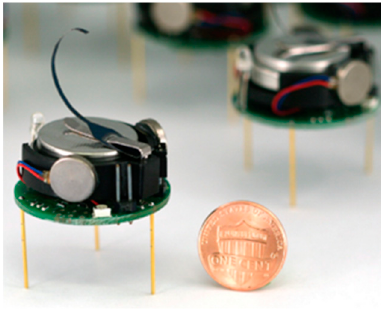
Figure 7. An individual Kilobot [31].